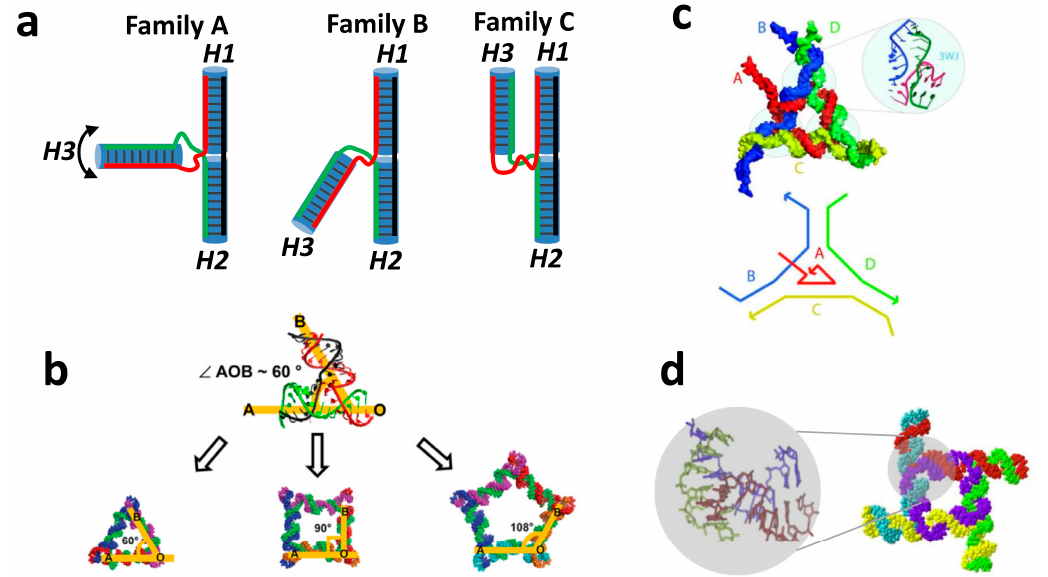
Figure 1. Examples of NANPs fabricated from RNA 3WJ. ( a ) Three RNA 3WJ families A, B, and C are differentiated based on the location of the Helix 3. ( b ) RNA polygons assembled from pRNA 3WJ, adapted with permission from Ref [13]. Copyright 2014 Oxford University Press. ( c ) RNA triangle assembled from 3WJ obtained from RNAJunction database accession ID 11836, adapted with permission from Ref [41]. Copyright 2011 American Chemical Society. ( d ) Planar RNA square nanoconstruct assembled from 3WJ found in large ribosomal subunit PDB I 2OGM, adapted with permission from Ref [42]. Copyright 2011 American Chemical Society.